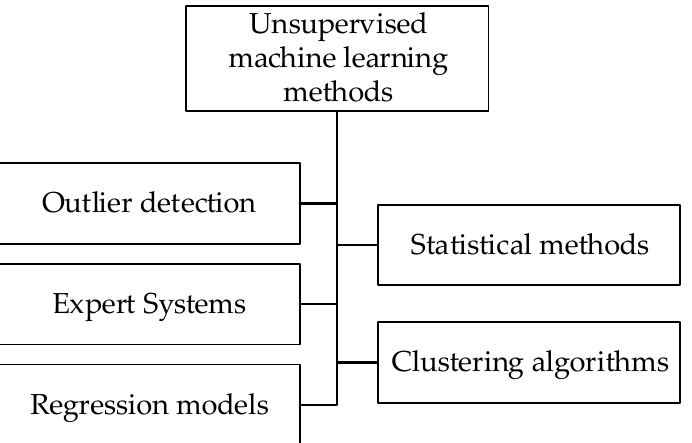
Figure 3. Unsupervised machine learning methods.